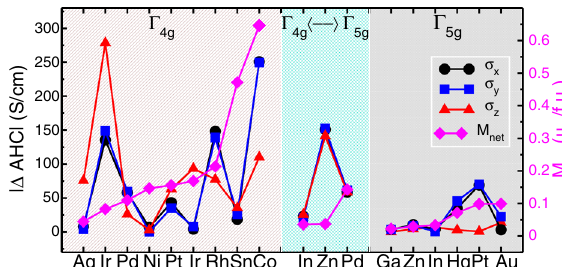
Fig. 4 Piezospintronic. The piezospintronic effect is illustrated by the change in AHC ( ∣ Δ AHC ∣ ) at 1% tensile strain and cubic phase. The ∣ Δ AHC ∣ and net magnetization is shown for the Cr 3 X N and Mn 3 XN antiperovskites (X and X are the elements present on the x -axis, respectively). The left, middle, and right panels correspond to the Γ 4 g , phase transition between Γ 4 g and Γ 5 g , and Γ 5 g state, Table 8). Explicit evaluations of the AHC for APVs in distorted Γ 4 g states verify the symmetry arguments, where the σ x and σ y components behave the same with respect to strain (see